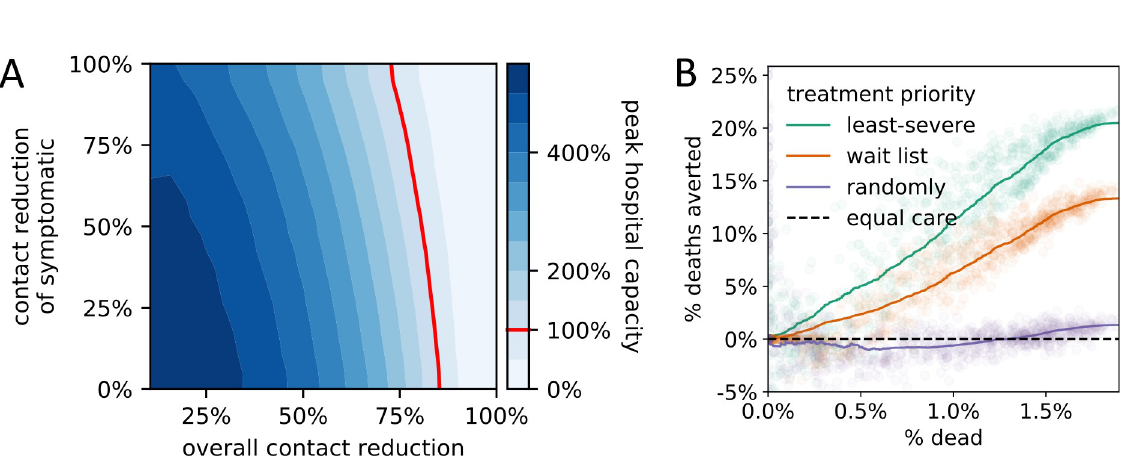
Fig 4. Peak hospital capacity and the effect of triaging policies. (A) Effect of population-wide contact reduction and additional contact reduction of symptomatic individuals on the projected peak hospital capacity. To the left of the hospital capacity threshold (red line), not all hospitalized individuals receive perfect care, resulting in longer recovery times and higher mortality. (B) Relative efficacy of four hospital triage policies at varying degrees of outbreak severity summarized by the average proportion of deaths (x-axis). Efficacies are computed by pairwise comparison of the projected death count with the imperfect-but-equal-care scenario.